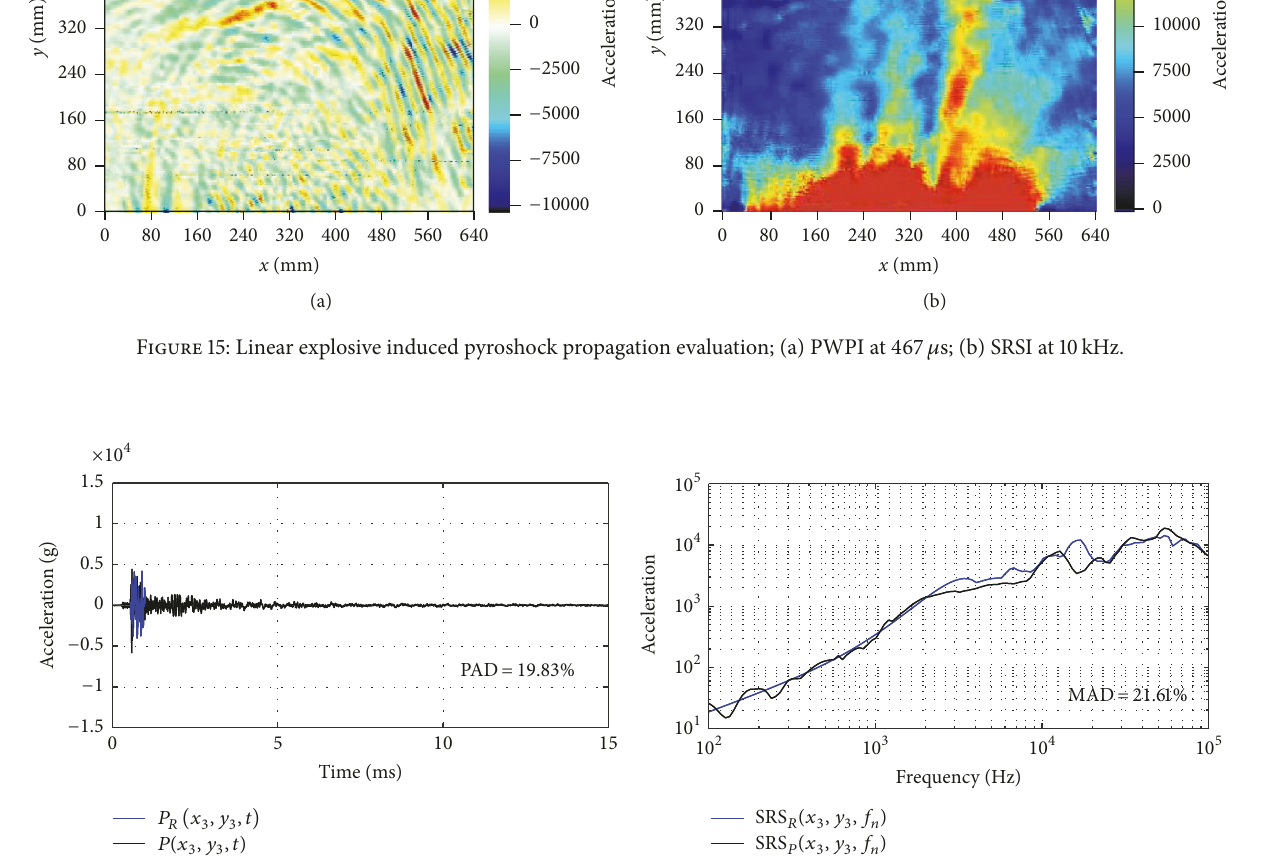
Figure 16: Time domain signal reconstruction at point 3, verification